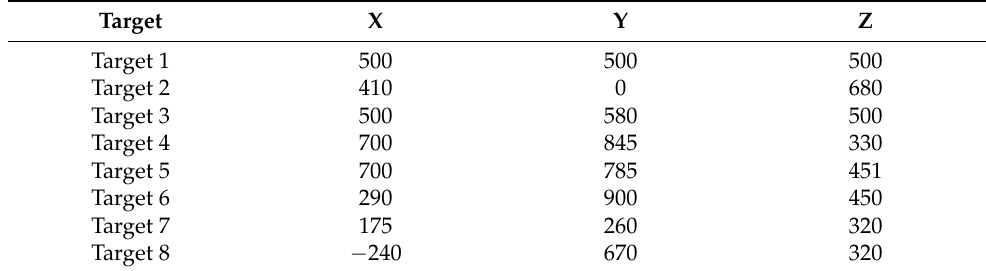
Table 3. Target positions [mm].